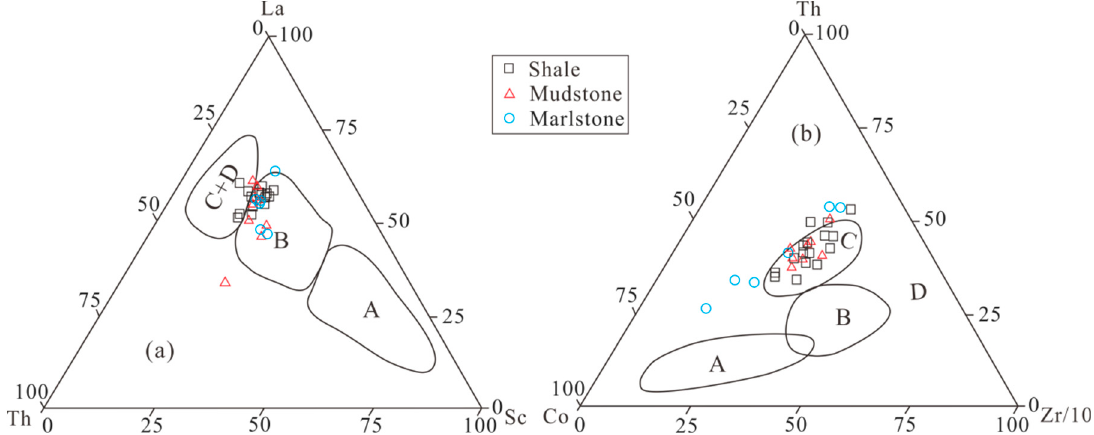
Figure 10. Tectonic setting discrimination diagrams of ( a ) La–Th–Sc and ( b ) Th–Co–Zr/10 for the black rock series from Zhenning section (base map after [58]). A: Oceanic island arc; B: Continental island arc; C: Active continental margin; D: Passive continental margin.